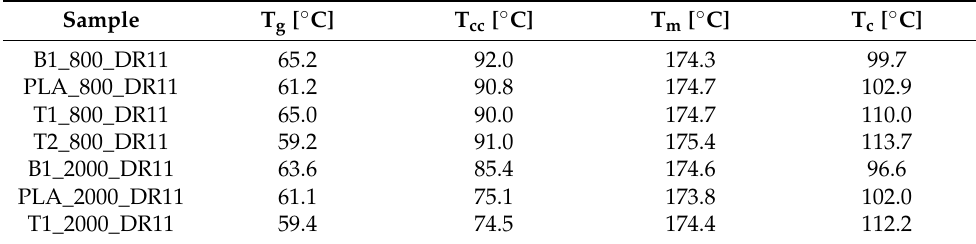
Figure 8. Differential scanning calorimetry data (exotherm down) for the first heating cycle at different take-up velocities and in the presence of different nucleating agents. ( a ) The first heating cycle at a take-up velocity of 800 m/min. ( b ) The corresponding crystallization peak during cooling. ( c ) The heating cycle at a take-up velocity of 2000 m/min. The curves are offset for visual clarity. Table 5. Differential scanning calorimetry data for Figure 8.